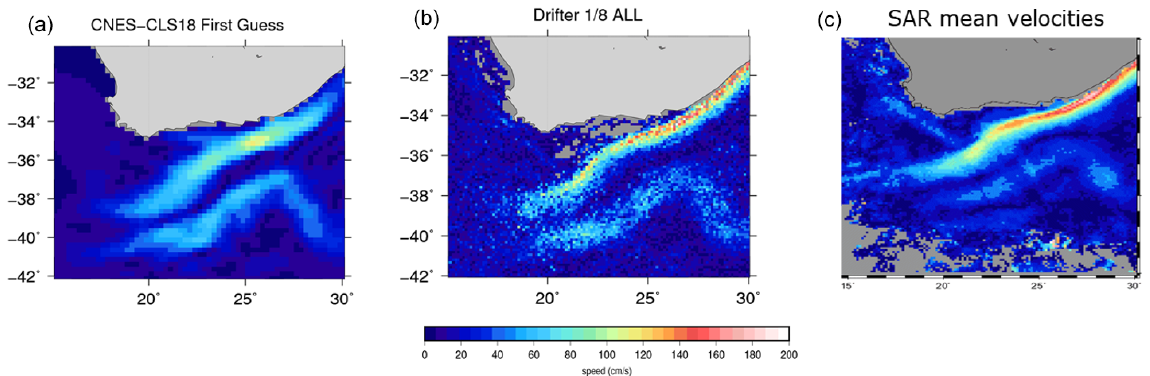
Figure 14. Mean velocities in the Agulhas Current area from (a) the GOCE-only derived MDT first guess, (b) drifting buoy velocities and (c) SAR-derived mean velocities.